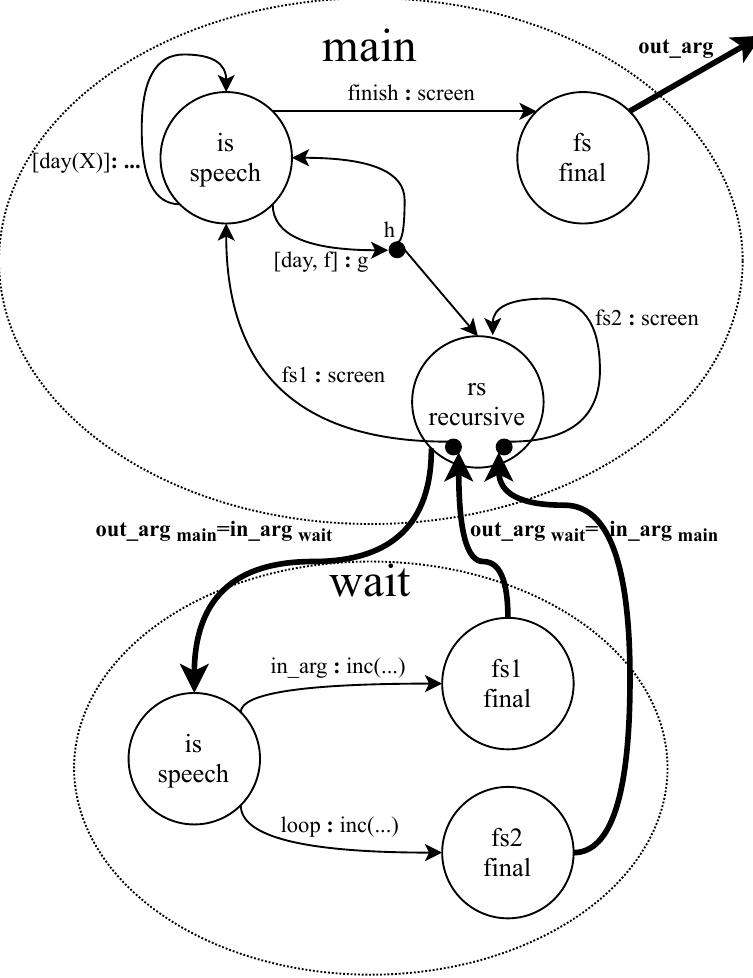
Figure 3. Graphical representation of an example dialogue model written in SitLog